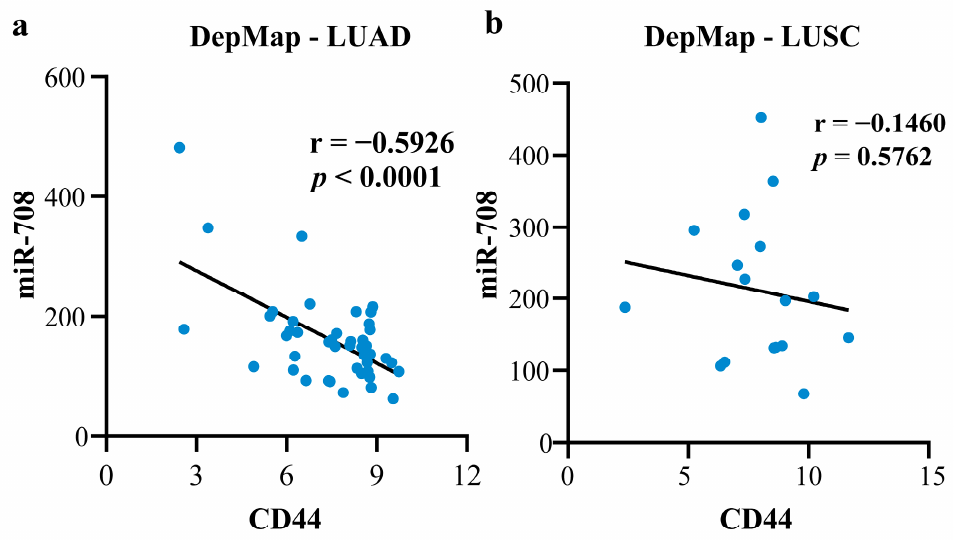
Figure 13. The correlation between miR-708 and CD44 in NSCLC cell lines: ( a ) The correlation between miR-708 and CD44 in LUAD cell lines; ( b ) The correlation between miR-708 and CD44 in LUSC cell lines.